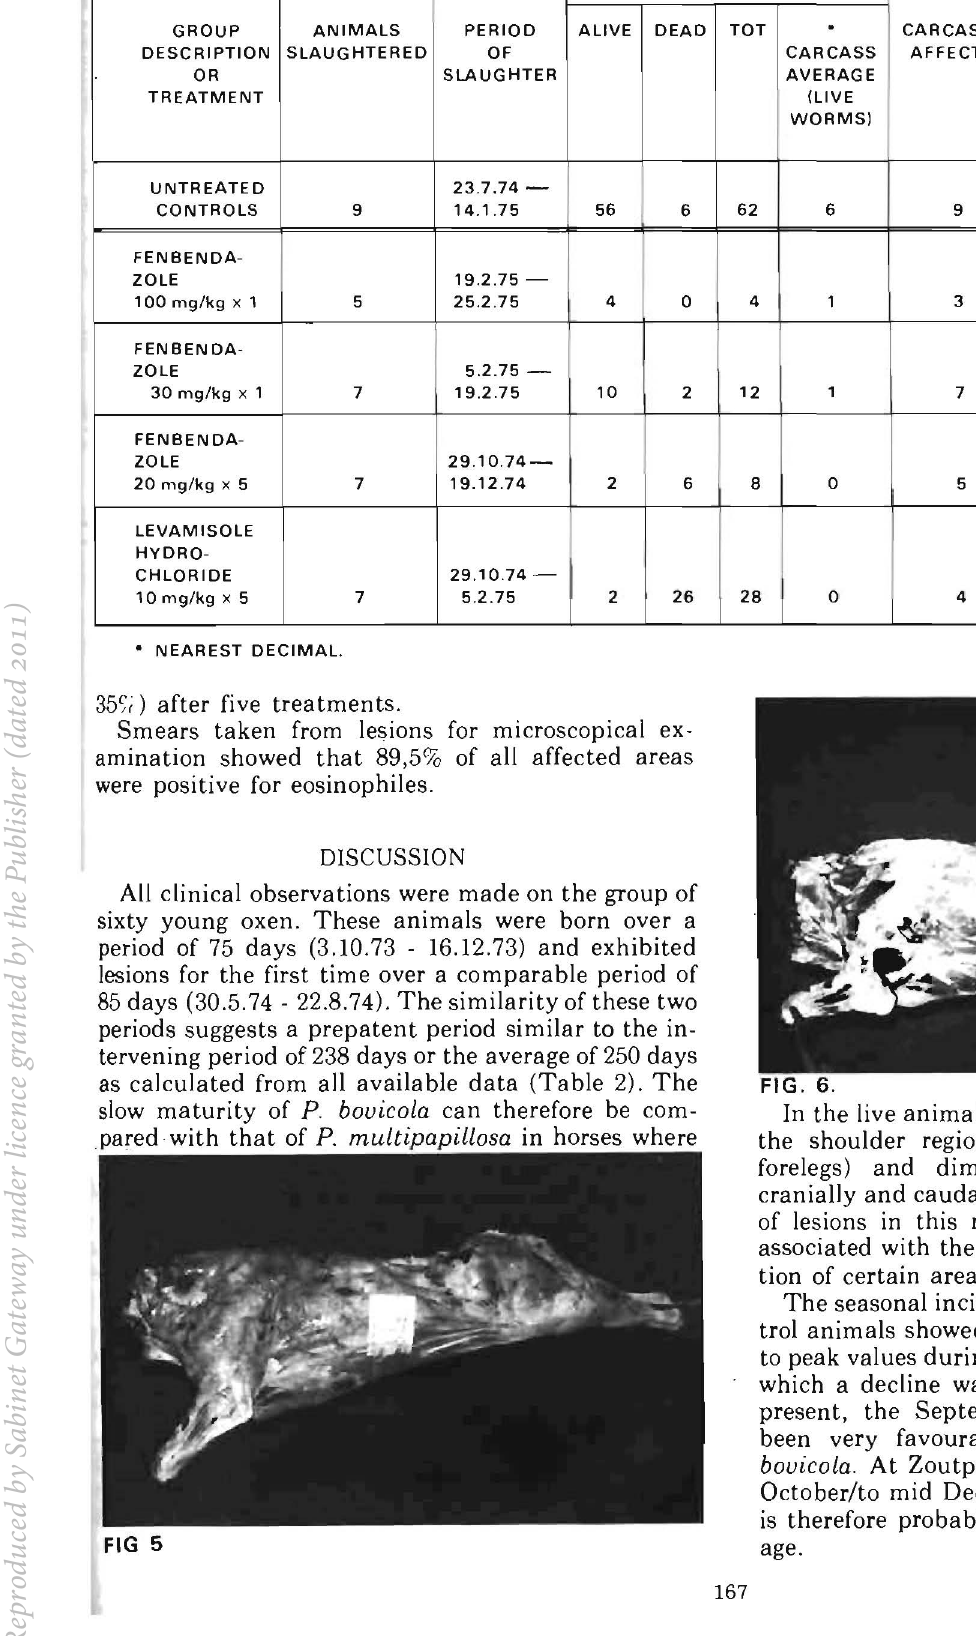
Table 5: EFFECT OF'TREATMENT ON P. bovicola, CARCASSES AFFECTED AND LESIONS OBSERVED P. bovicola WORMS OBSERVED LESIONS